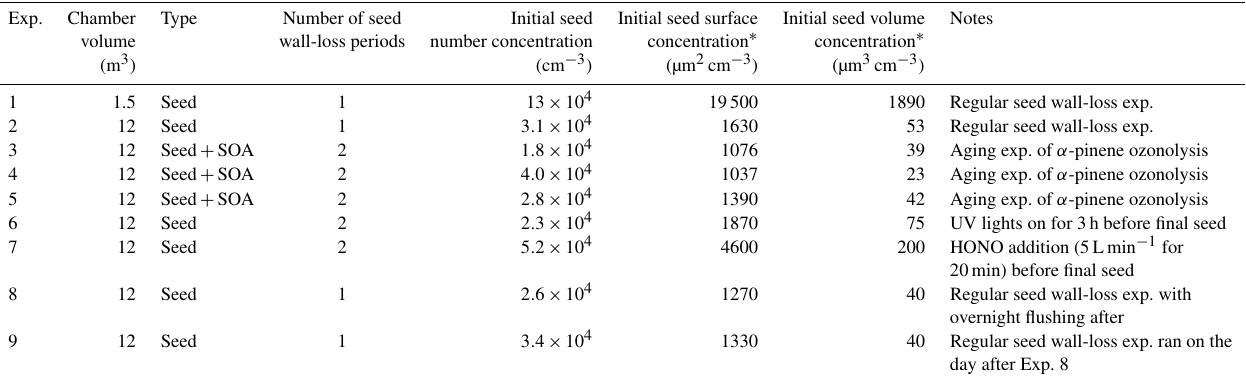
Table 1. List of experiments and experimental conditions. Exp. Chamber